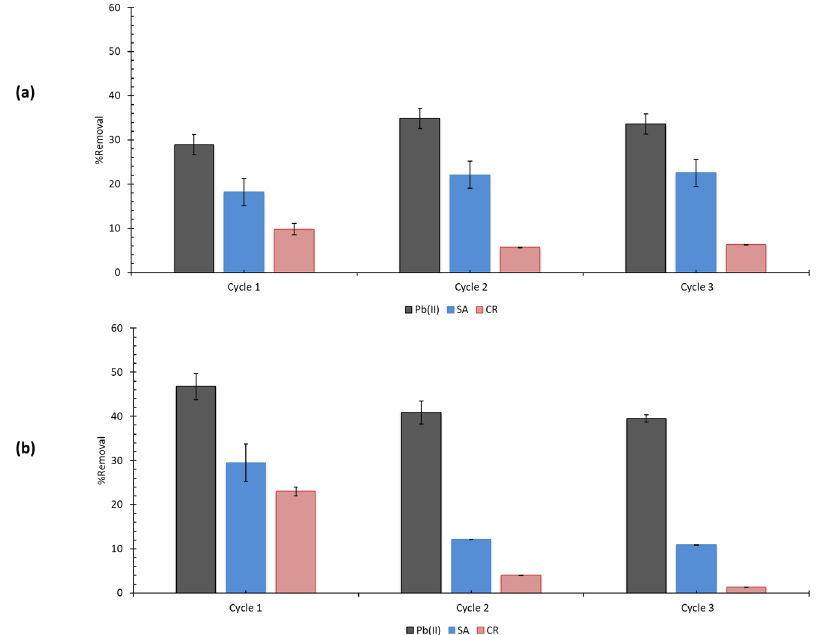
Figure 8. Regeneration of CsXM after adsorption of Pb (II), SA, and CR using 0.1 N HCl for the former and 0.1 N NaOH for the latter two at doses of 0.67 g/L ( a ) and 1.33 g/L ( b ). Error bars are expressed as mean value ±SD.